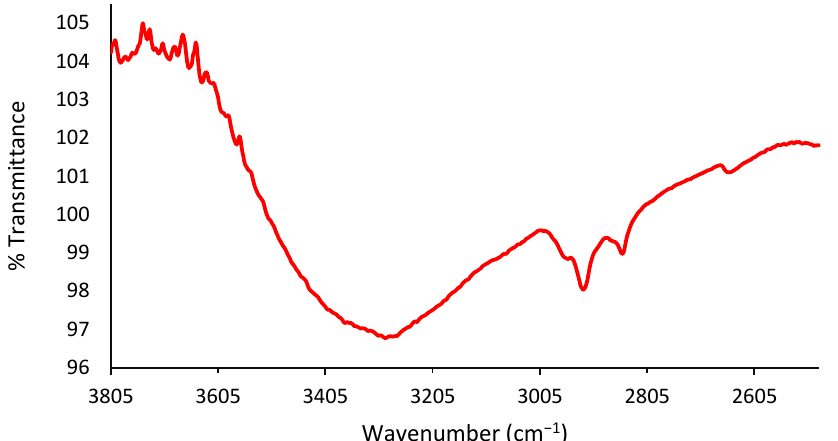
Figure 3. CH 2 symmetric stretching transmittance band is observed at 2851 cm − 1 ; CH 2 asymmetric bending transmittance is observed at 2952 cm − 1 . OH- stretching vibrations band is centered at 3293 cm − 1 .